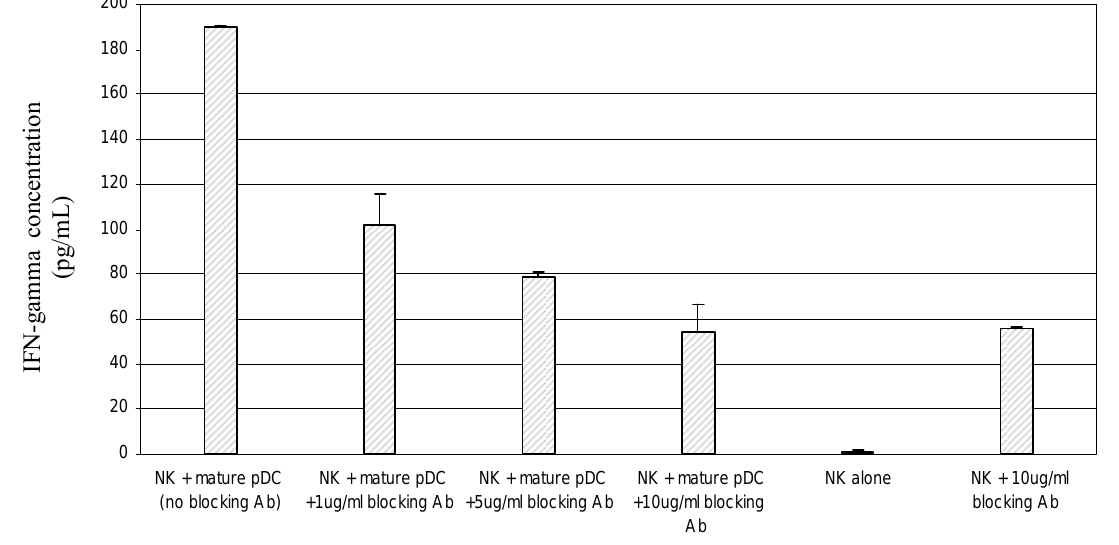
Figure 6. pDC stimulate NK secretion of IFN γ and is dependent on signalling through the type 1 interferon